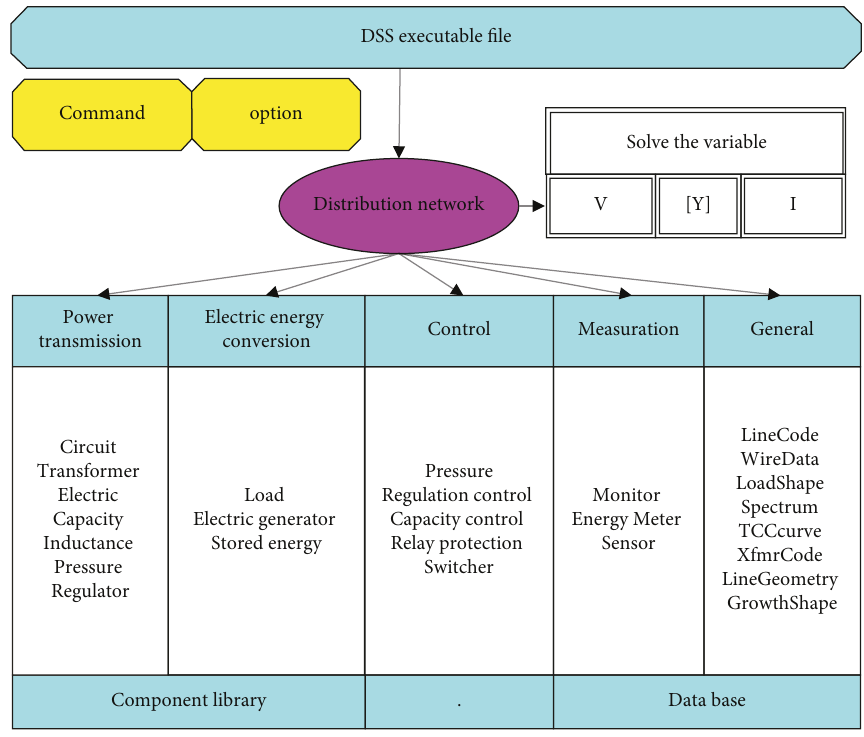
Figure 1: OpenDss programming structure.